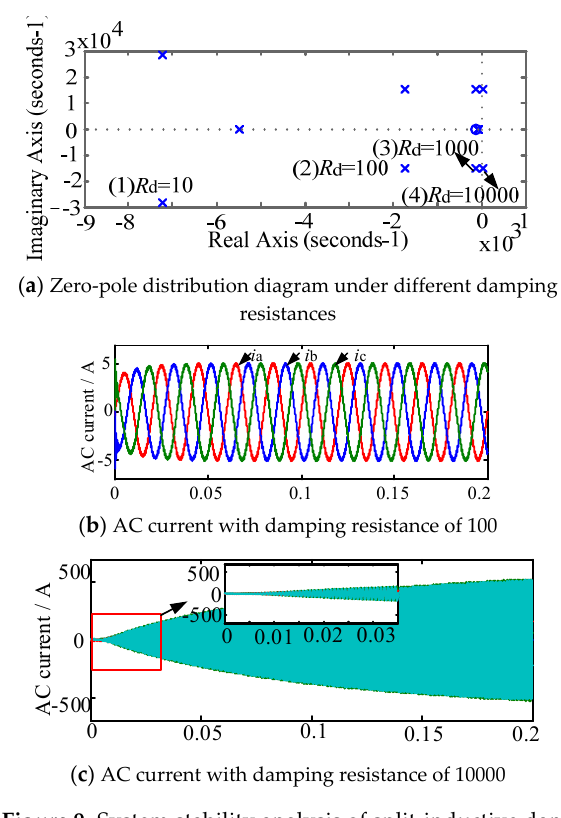
Figure 9. System stability analysis of split-inductive damping solution 2. ( a ) Zero-pole distribution diagram under different damping resistances; ( b ) AC current with damping resistance of 100; ( c ) AC current with damping resistance of 10,000.